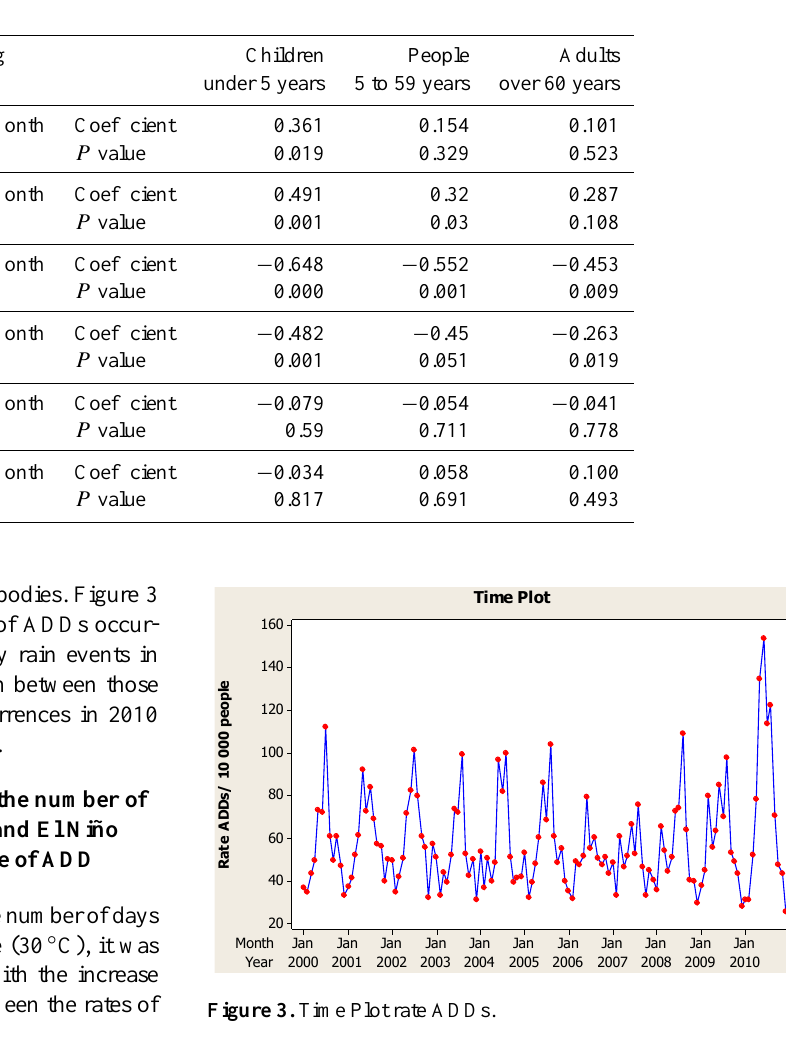
Table 2. Spearman’s correlation analysis between diarrhoea diseases and El Niño, La Niña and neutral conditions in Aguascalientes, Mexico from 2000–2010.